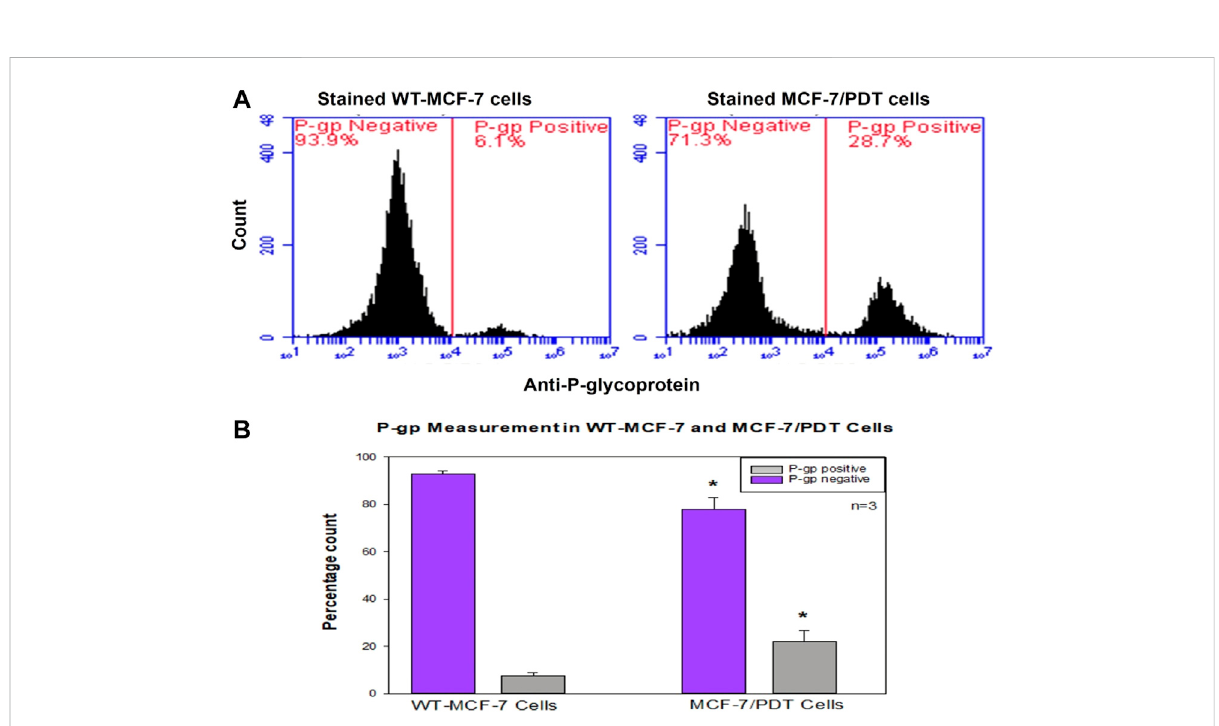
FIGURE 2 Flow cytometry measurement of P-glycoprotein expression in WT-and MCF-7/PDT cells. (A) Histogram expression of P-glycoprotein in both cells where MCF-7/PDT cells have a slight p-gp of 28.7% compared to 6.1% in WT-MCF-7 cells. (B) Bar chart representation of three independent repeats with signi fi cant difference ( p = 0.040) of compared p-gp measurement in WT-and MCF-7/PDT